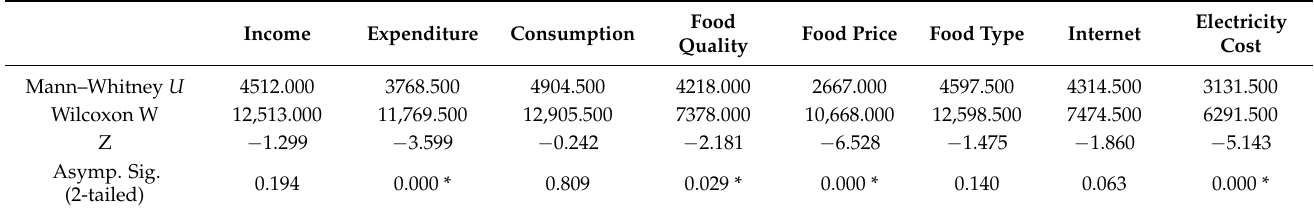
Table 3. Mann–Whitney analysis for the COVID-19 impact on Arabica and Robusta farmers’ households.